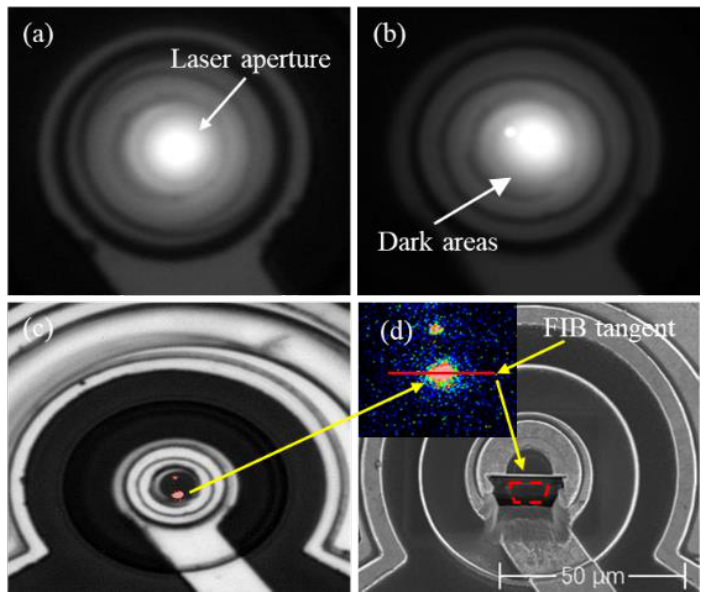
Figure 10. ( a ) Forward biased EL image before aging and ( b ) Forward biased EL image after aging. ( c ) Reverse bias EMMI image. ( d ) The incision position of FIB-SEM image.